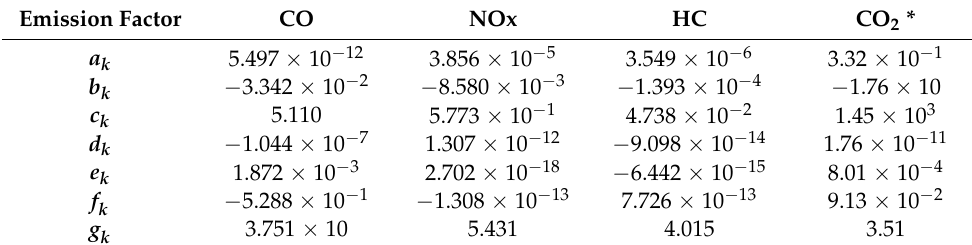
Table 2. COPERT emission model parameter table